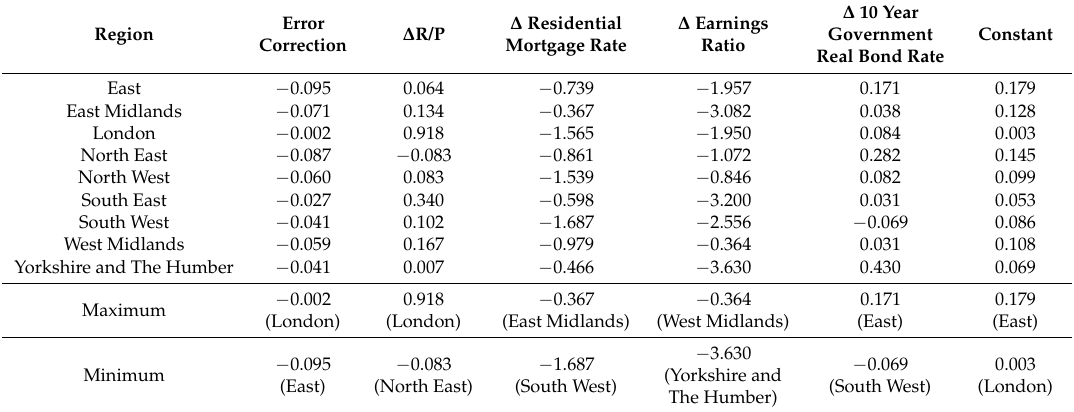
Table 4. Sum of short-run coefficients for each region from PMG estimation of Model B1. ∆ Residential Error ∆ R/P Region Mortgage Rate Correction